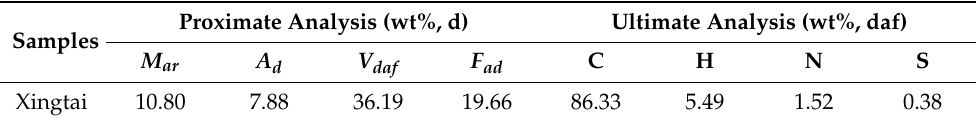
Table 1. The physical and chemical properties of coking coal [23].